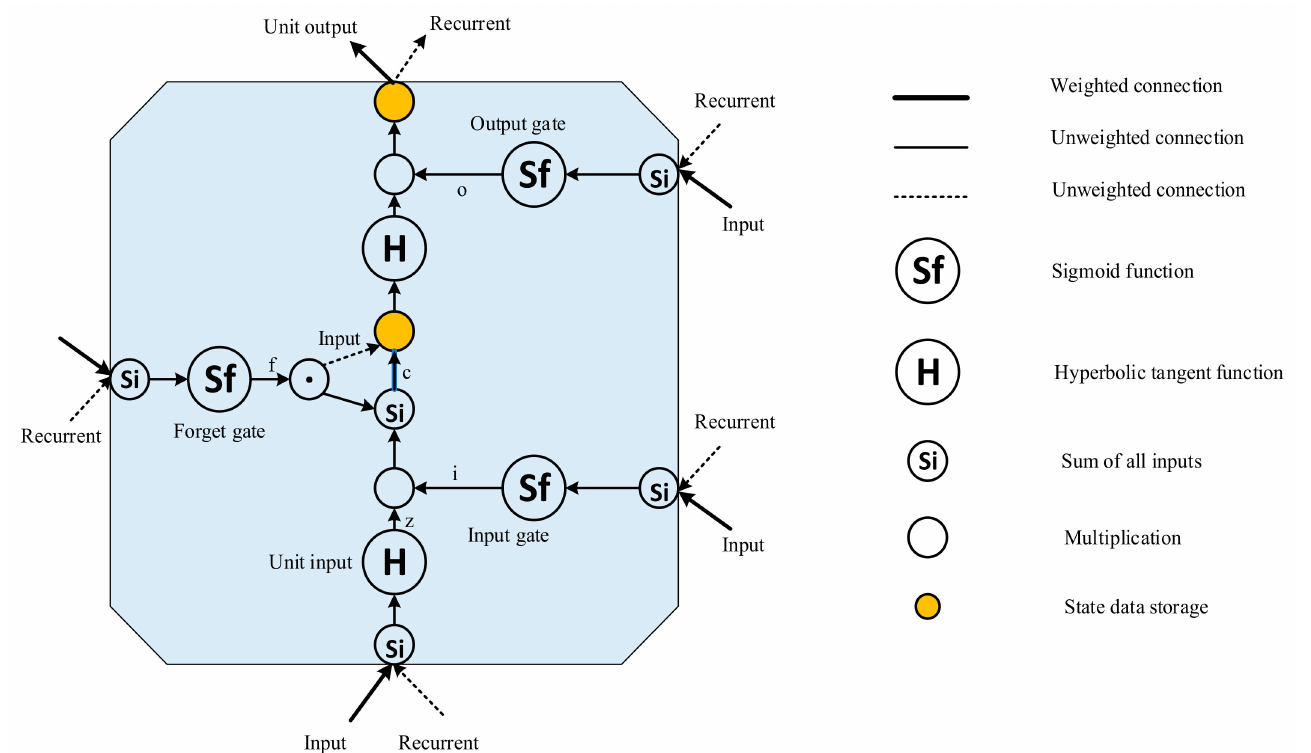
Figure 8. Data processing in a simplified long short-term memory (LSTM)